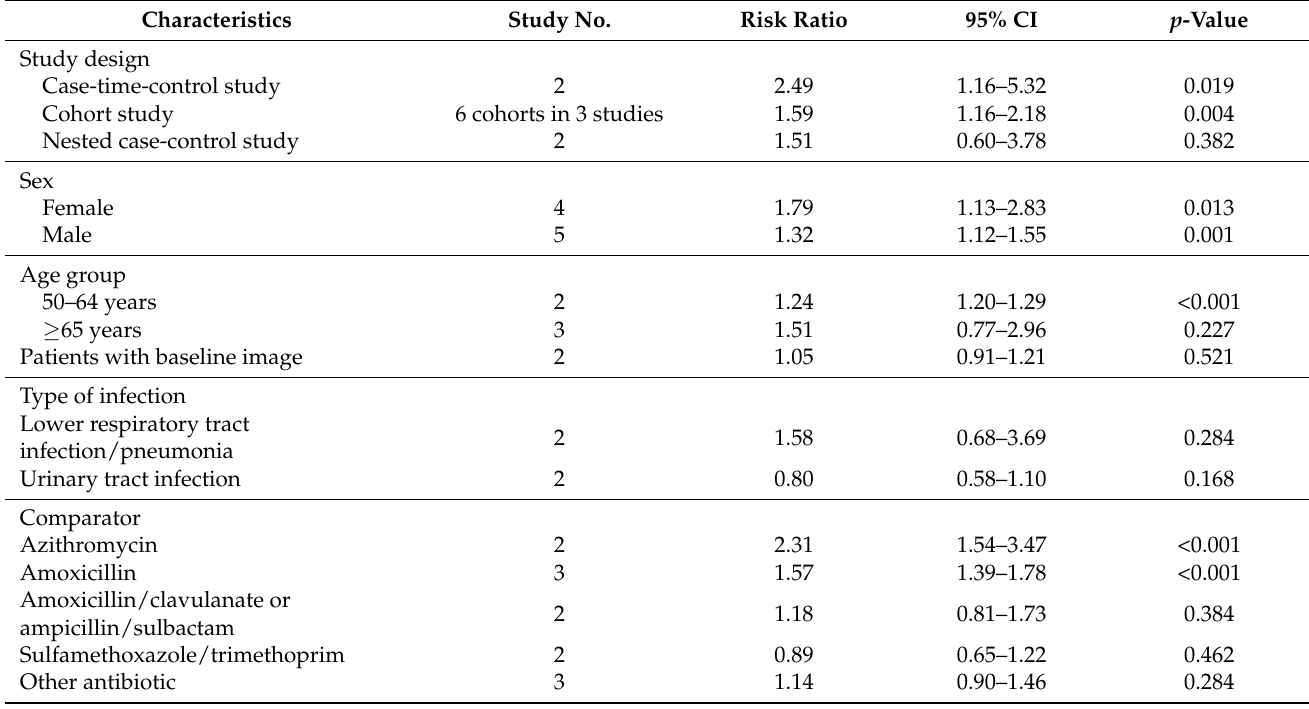
Table 2. Subgroup